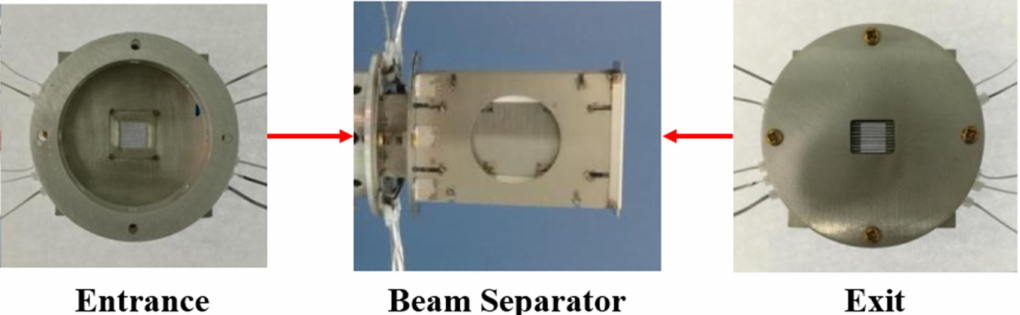
Figure 5. Physical drawing of separator: the left section is the entrance of beam separator, the centre part is the whole beam separator, and the right section is the shape of exit side.(The arrow in the figure is used to mark the